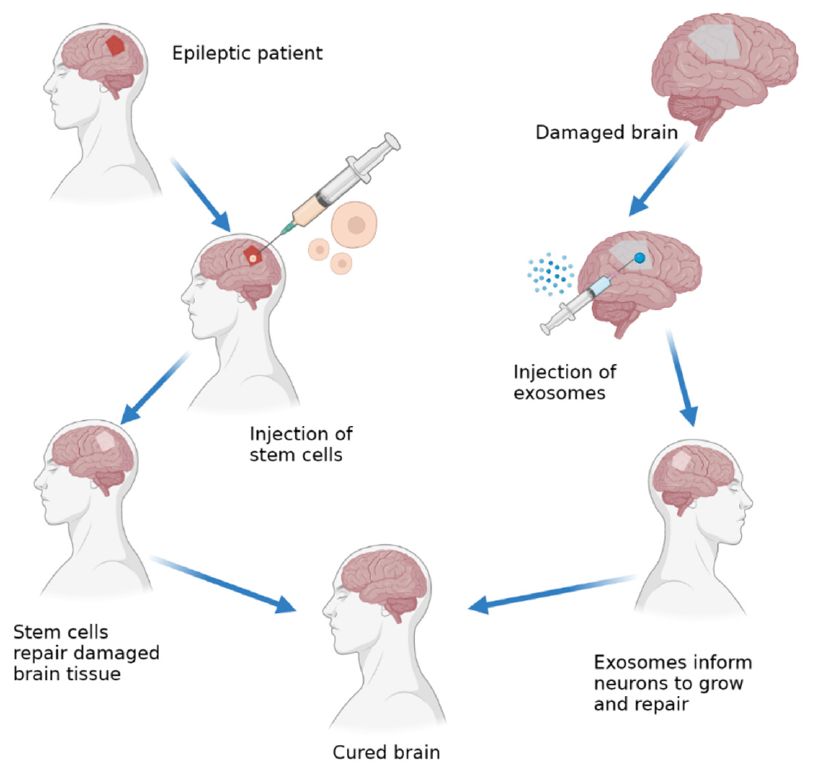
Figure 5. Stem cell and exosome methods of use to treat epilepsy.